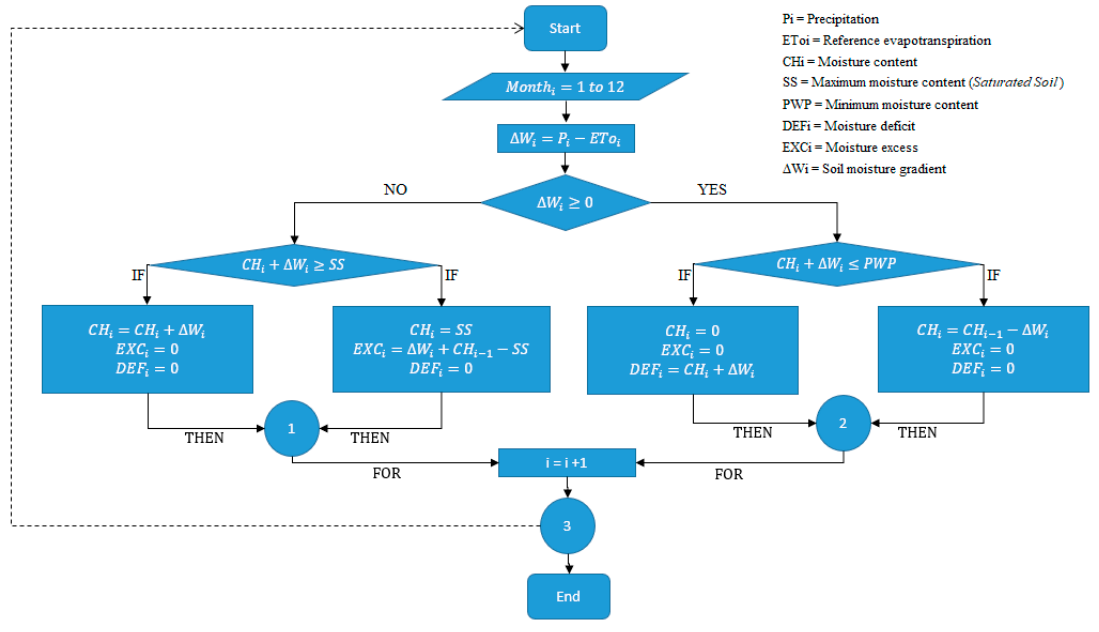
Figure 3. Methodological scheme for calculating the water balance.